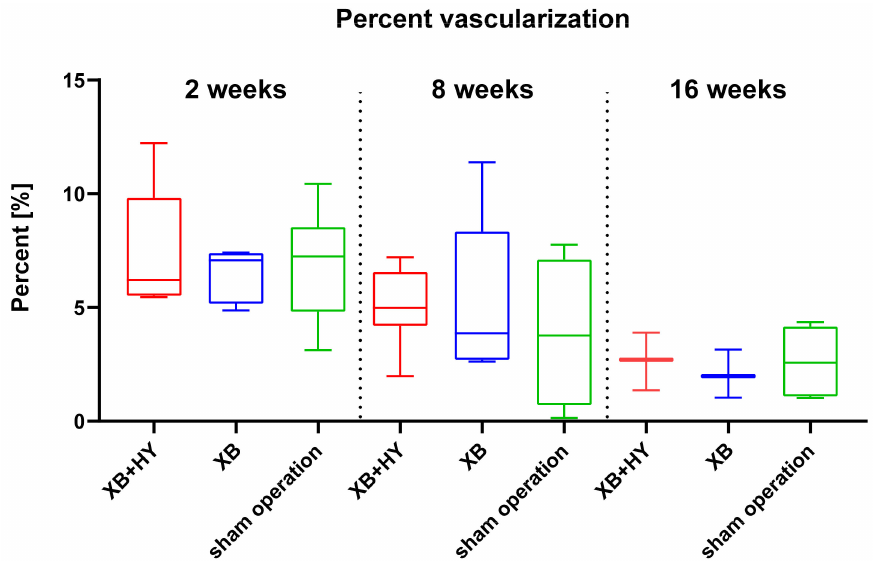
Figure 9. Results of the histomorphometrical analysis of the vascularization within the implantation beds presented as mean and standard deviation (in percent